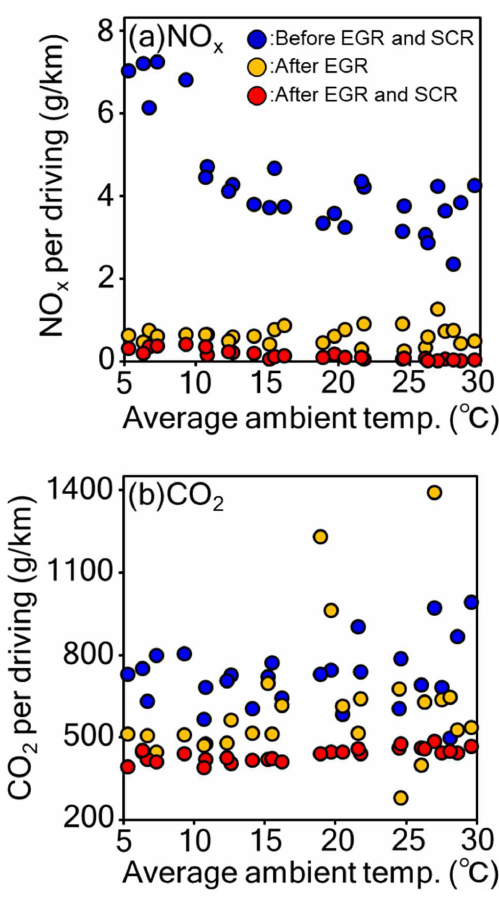
Figure 2. Relationships between ambient temperature and total amount of (a) NO x and (b) CO 2 emissions per driving distance (g/km). Each plot was obtained from morning and afternoon tests conducted in four seasons (the experiments were conducted for a period of 5d in each season). Average ambient temperatures were determined using the average value of the temperatures recorded during each driving